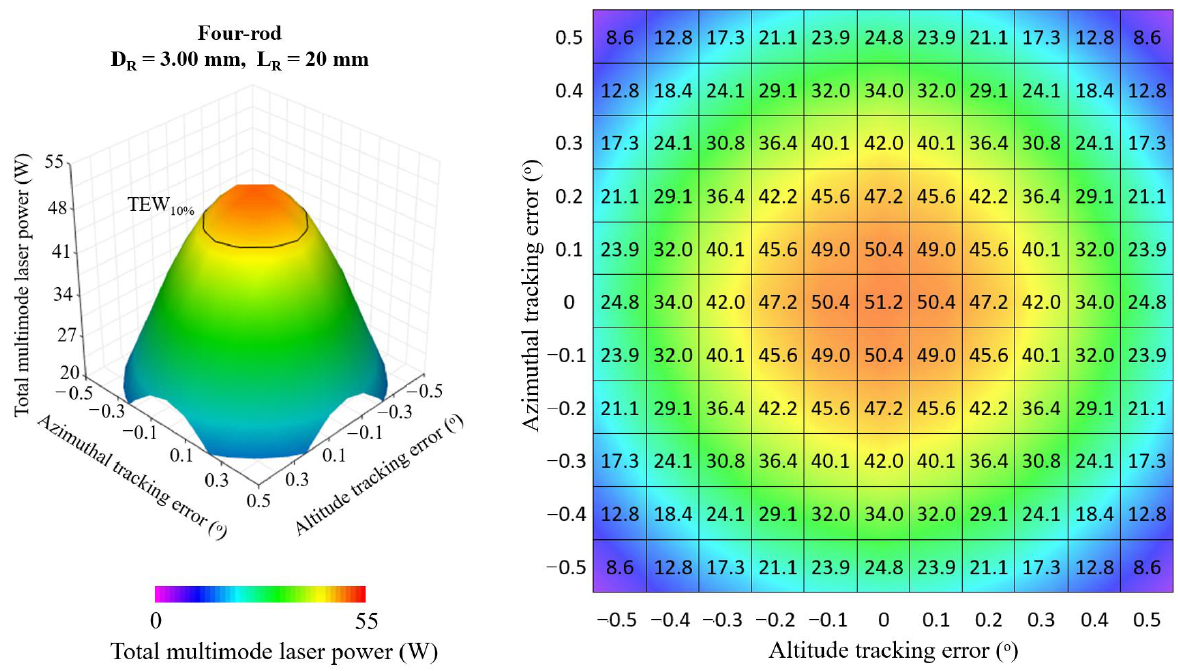
Figure 9. Total multimode solar laser power as a function of the simultaneous tracking error in altitude and azimuthal directions, ranging from the optimal alignment (0.0 ◦ ) to 0.5 ◦ , for the four-rod scheme with D R = 3.00 mm and L R = 20 mm.